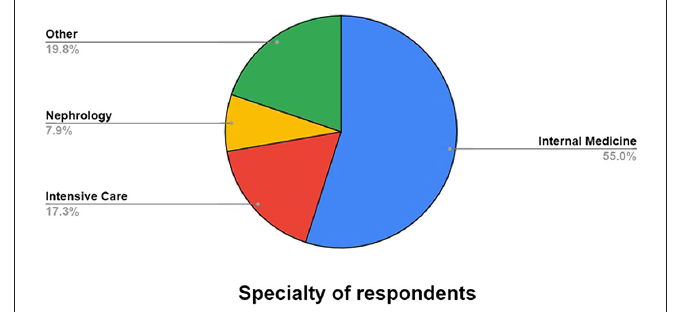
Figure 1. Specialty of